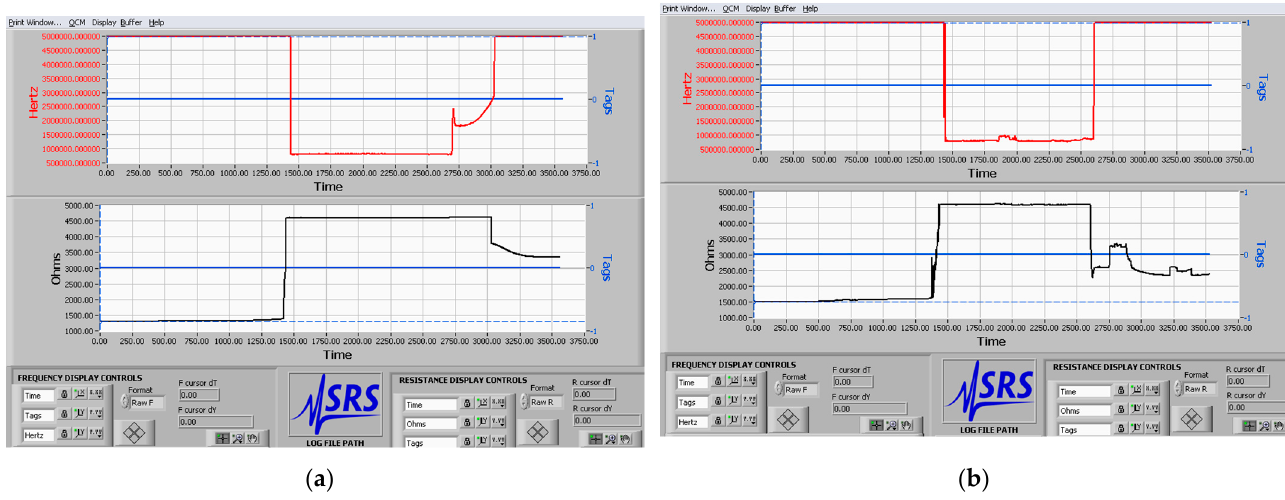
Figure 4. Real-time sensor response of two 5 MHz soot coated QCMs triggered by the ( a ) bulk and ( b ) contour freezing of a 50 µ L water droplet placed in the middle of the sensing surface. The graphs are directly snapped from the PC’s screen instead of being processed by a specific software (e.g., OriginLab), with an aim of proving the authenticity of our experi- ments.